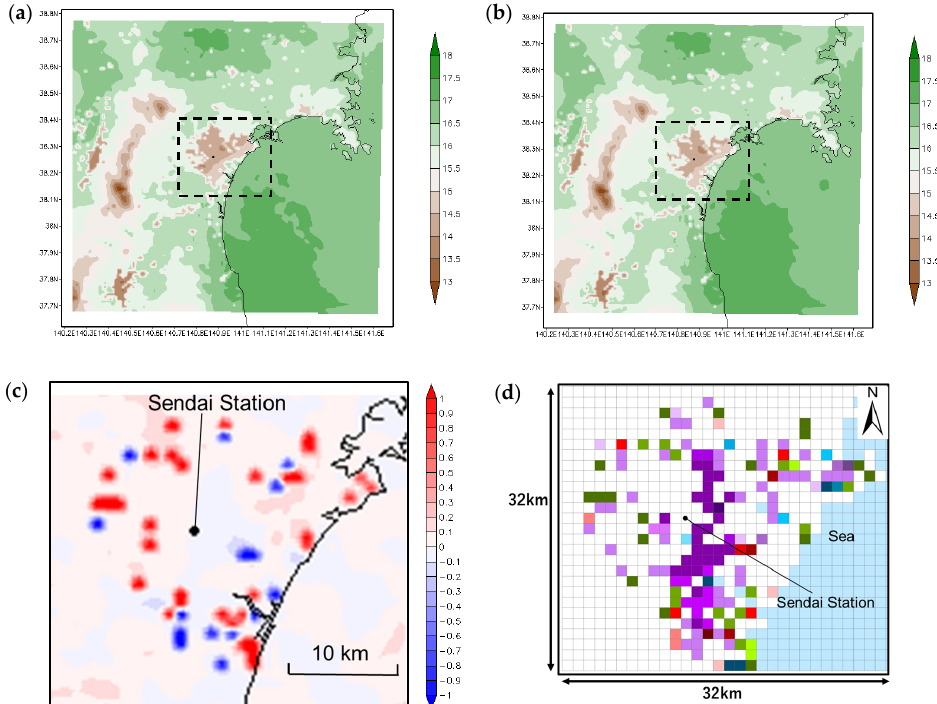
Figure 8. Daytime air temperature {°C} distributions. ( a ) In Case lu_2002; ( b ) in Case lu_2022; ( c ) air temperature differences (between Case lu_2022 and Case lu_2002); and ( d ) land use changes between 2002 and 2022 in Sendai (reposted Figure 4).